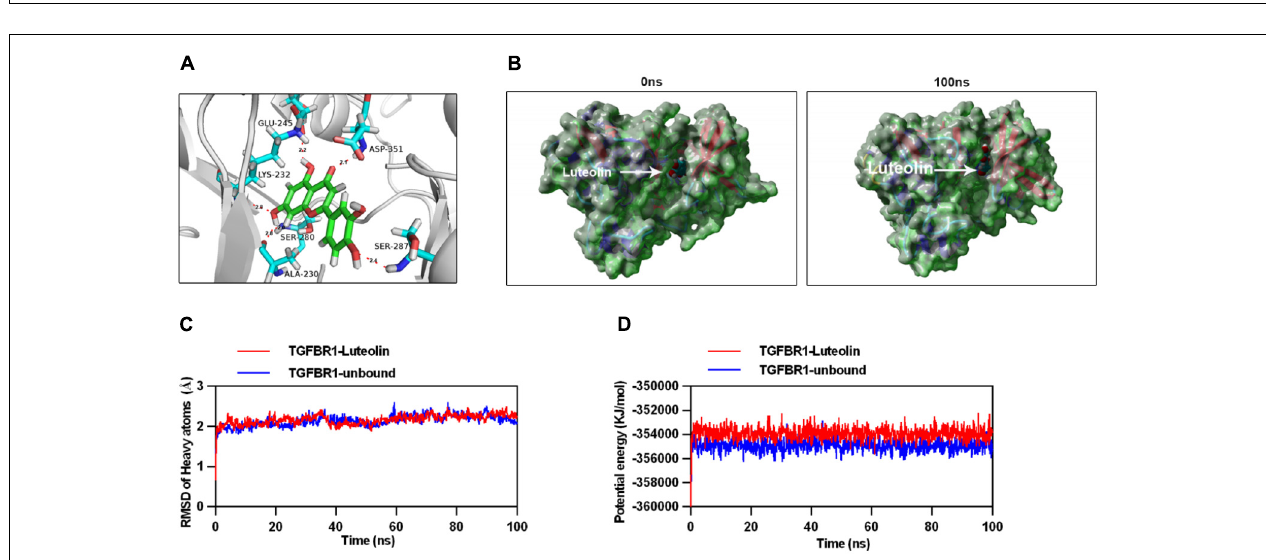
FIGURE 7 | Molecular docking and simulation of the molecular dynamics. (A) Three-dimensional crystal structure of luteolin (ZINC18185774) in complex with TGFBR1 (PDB ID: 1PY5). Luteolin is shown in green , and the hydrogen bonds are indicated by sky-blue lines . (B) Surface presentation of the TGFBR1-luteolin complex crystal structure at 0 and 100 ns. (C) Plots of root mean square deviation (RMSD) of heavy atoms of TGFBR1 unbound ( blue ) and TGFBR1-luteolin complex ( red ). (D) Potential energy profiles of TGFBR1-free ( blue ) and TGFBR1-luteolin complex ( red ) during the 100-ns molecular dynamics simulation.